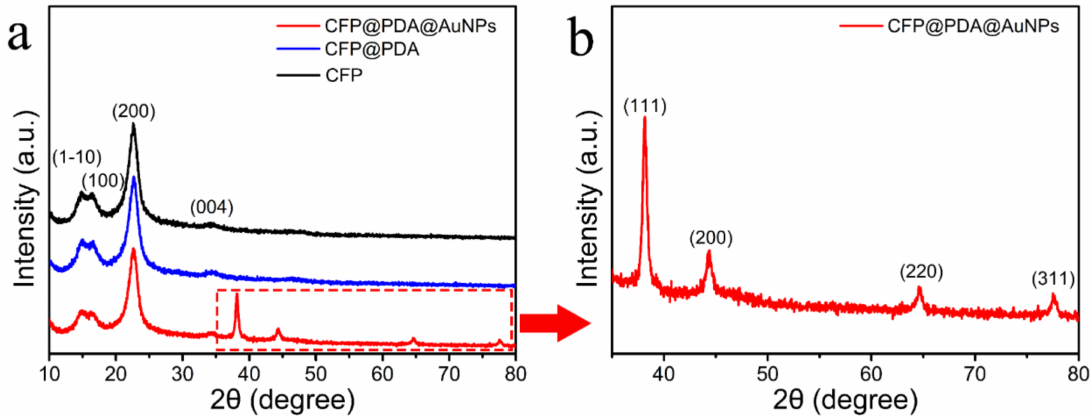
Figure 3. ( a ) XRD diffractogram for the pristine CFP, CFP@PDA and CFP@PDA@AuNPs. ( b ) High resolution XRD diffractogram of the CFP@PDA@AuNPs